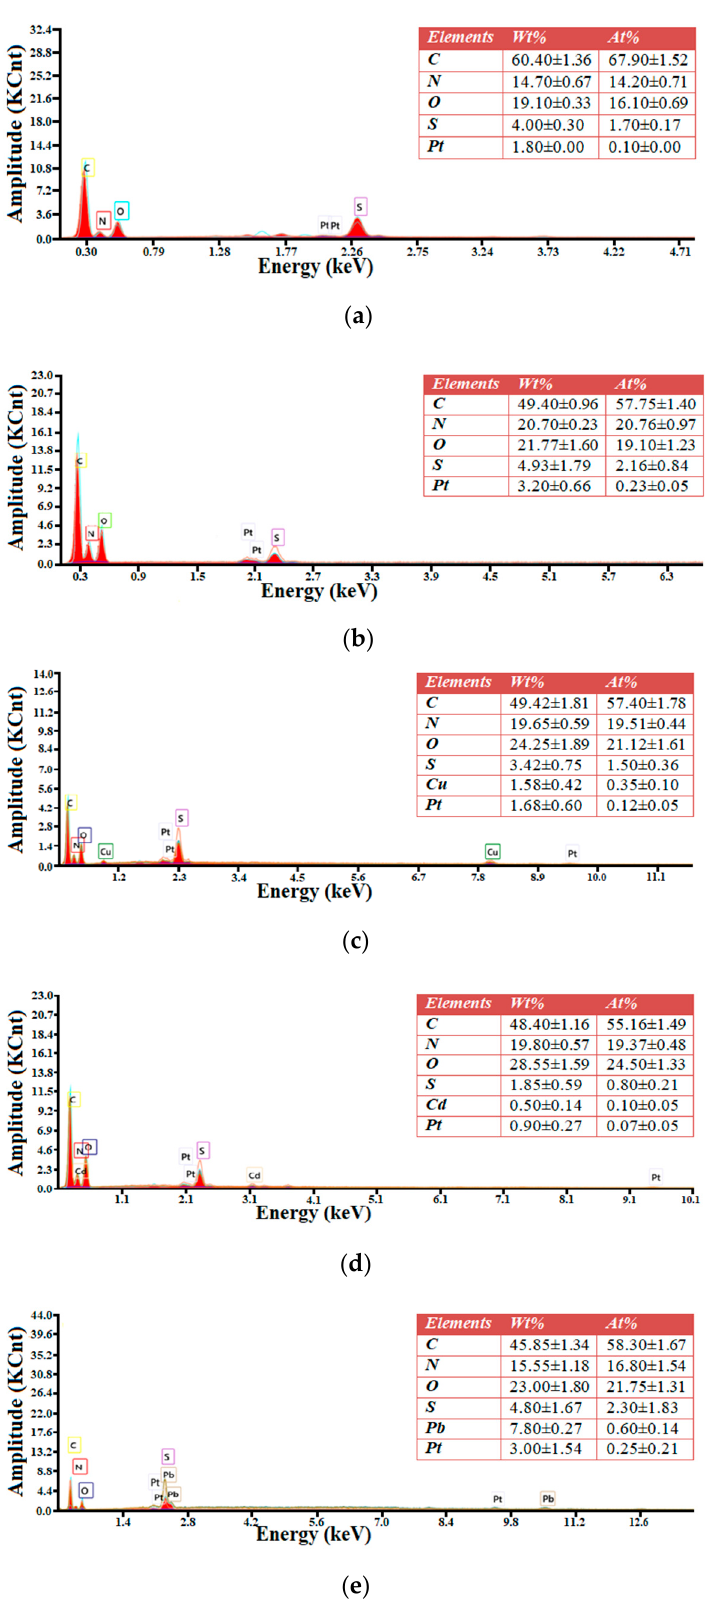
Figure 2. EDX spectra and the elemental composition (inset) of: ( a ) oxidized wool fibers, ( b ) oxidized wool fibers, ( c , d , e ) oxidized wool fibers loaded with Cu 2+ , Cd 2+ , respectively Pb 2+ .